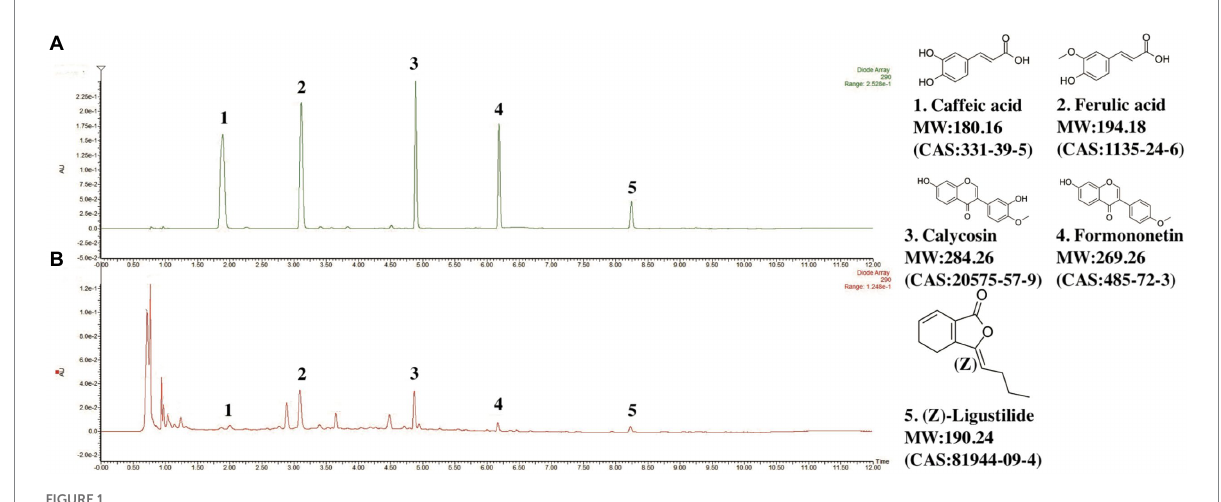
FIGURE 1 Chromatograms of representative components in DBD. (A) Chromatogram of standard mixture of 5 ingredients. (B) Chromatogram of DBD. Observation wavelength ( λ ) = 290